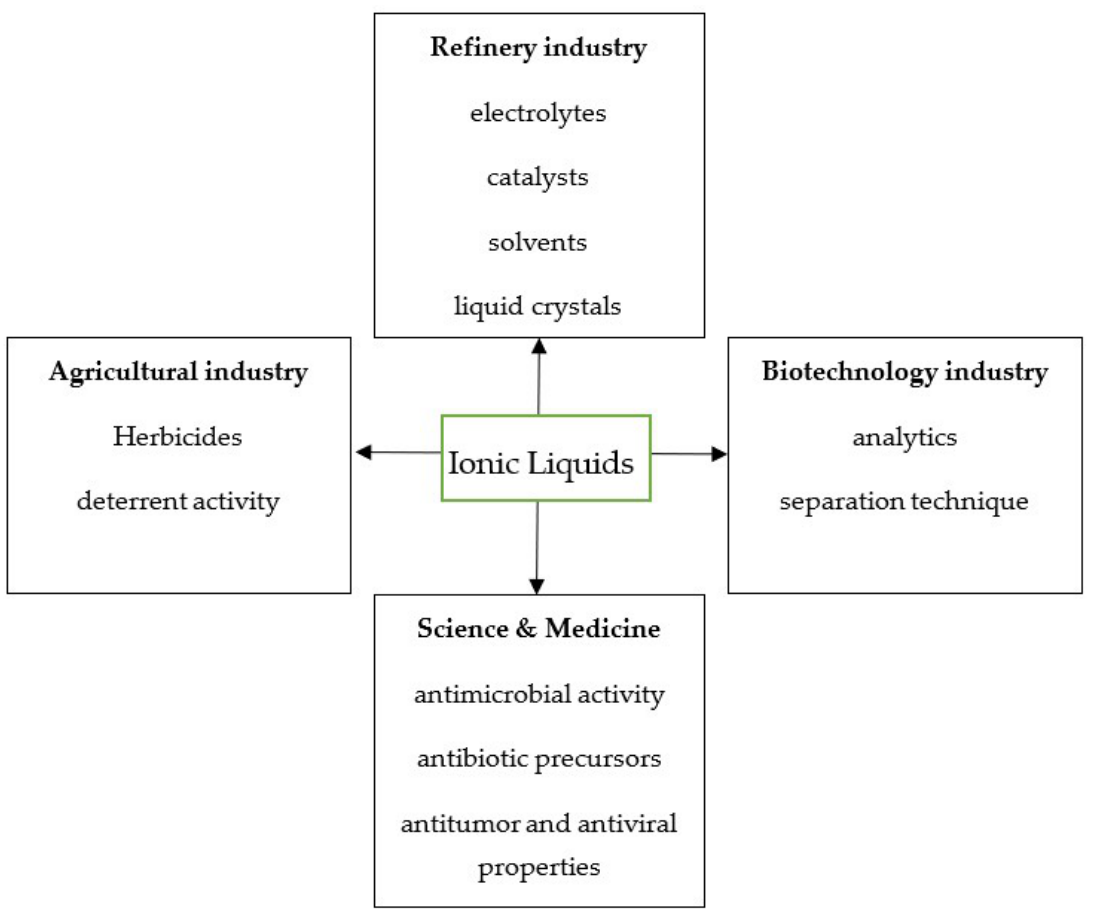
Figure 1. The chart summarizes main properties and their current applications of ionic liquids